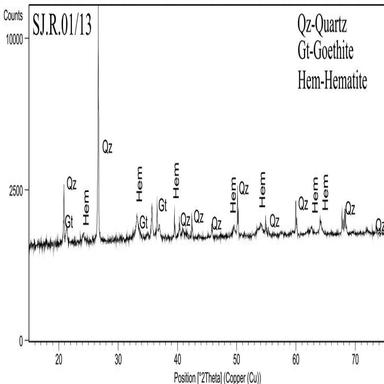
FSS X-ray diffraction (XRD) pattern (sample SJ.R.01/13: base of the corner of the N. Sra. Da Conceição bulwark), in which there are domains of quartz, goethite and restricted hematite.